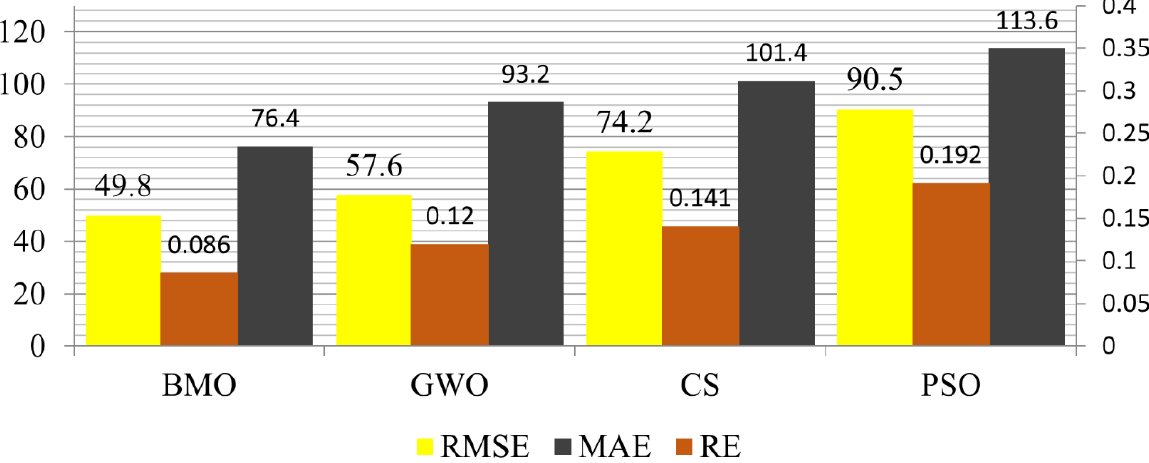
Figure 23. RMSE, MAE, and RE.